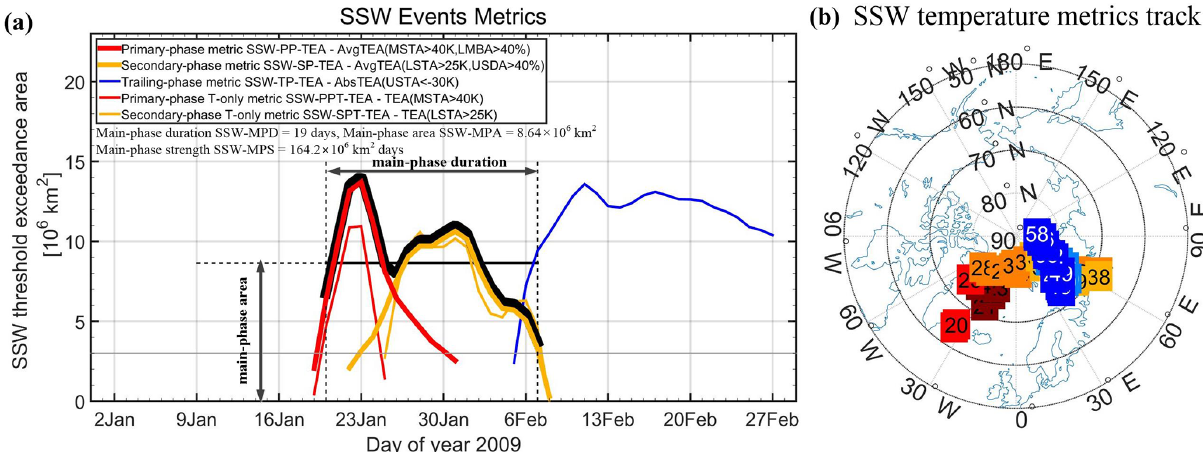
Figure 7. Time evolution of the daily primary-phase (heavy red), secondary-phase (heavy yellow), trailing-phase (light blue), primary- phase temperature-only (light red), and secondary-phase temperature-only (light yellow) metrics, respectively (a) , shown for daily TEAs exceeding a TEA Min of 3 × 10 6 km 2 (plus a day before and after). The main-phase metrics envelope for computing the main-phase area and duration (heavy black) and the related area, duration, and strength indicator results are depicted as well (numeric results in legend), and the TEA Min threshold is indicated (gray horizontal line). For complementary space–time dynamics information, the geographic tracks and magnitude classes of the three metric-relevant temperature anomalies (MSTA red, LSTA yellow, USTA blue) are also shown for days with TEAs > TEA Min ( b ; style as in the right column of Fig.